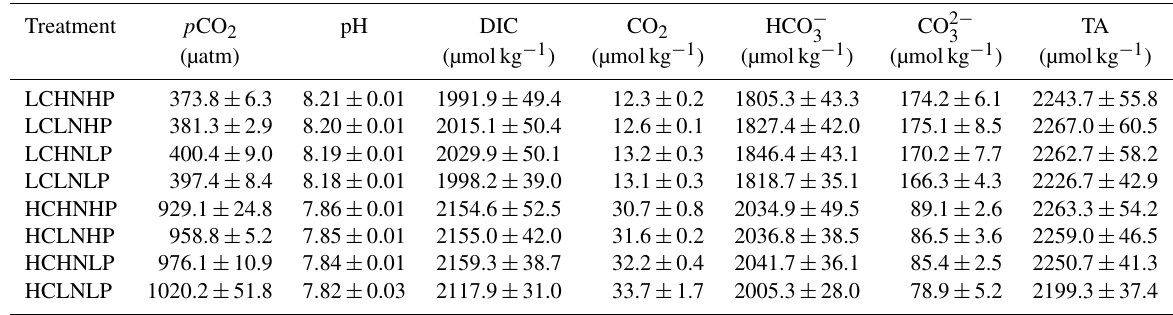
Table 1. Parameters of the seawater carbonate system in different cultures. LC, 400µatm; HC, 1000µatm; LN, 6.1µmolL − 1 ; LP, 0.2µmolL − 1 ; HN, 106.1µmolL − 1 ; HP, 10.2µmolL − 1 . DIC = dissolved inorganic carbon, TA = total alkalinity. Data are the means ±